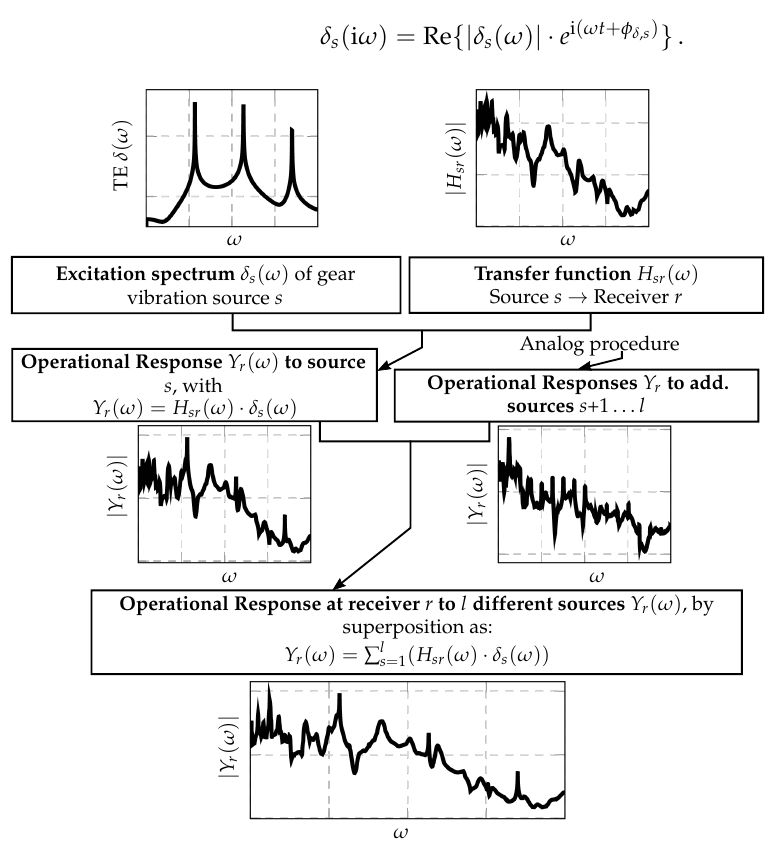
Figure 14. Approach for the dynamic response of any DoF r under operating conditions to l different gear-induced vibration sources. The dynamic transmission error spectra δ s ( ω ) of the the s -th gear stage is calculated from an analytical model of the transient gear dynamics. A finite element model of the gearbox is used for harmonic response analyses, to obtain transfer functions H sr ( i ω ) from TE excitation of the s -th gear stage to the r -th DoF of the gearbox, as shown in Equation (25). The response under operating conditions of the r -th DoF Y r ( ω ) is calculated as a linear combination of excitation spectra and transfer functions. In case of multiple excitation sources, the operational response spectrum is obtained by superposition of the specific source